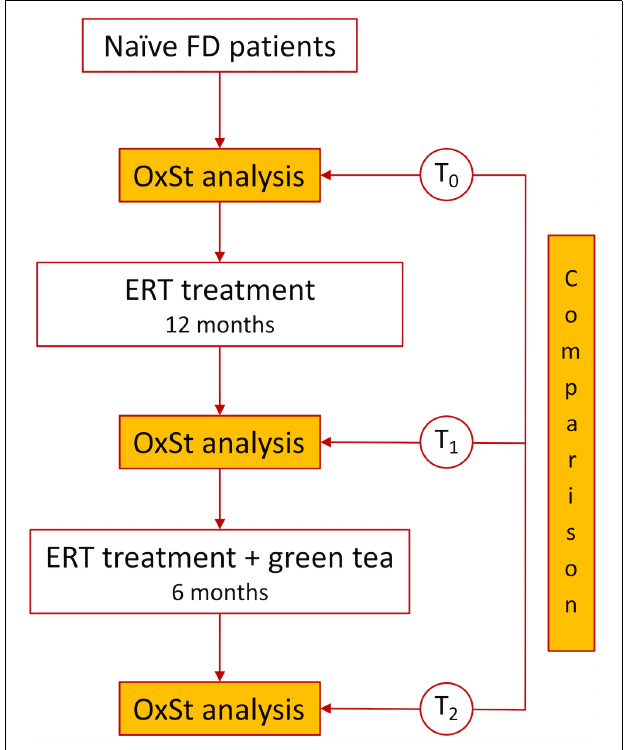
FIGURE 1 | Flow chart of the study.